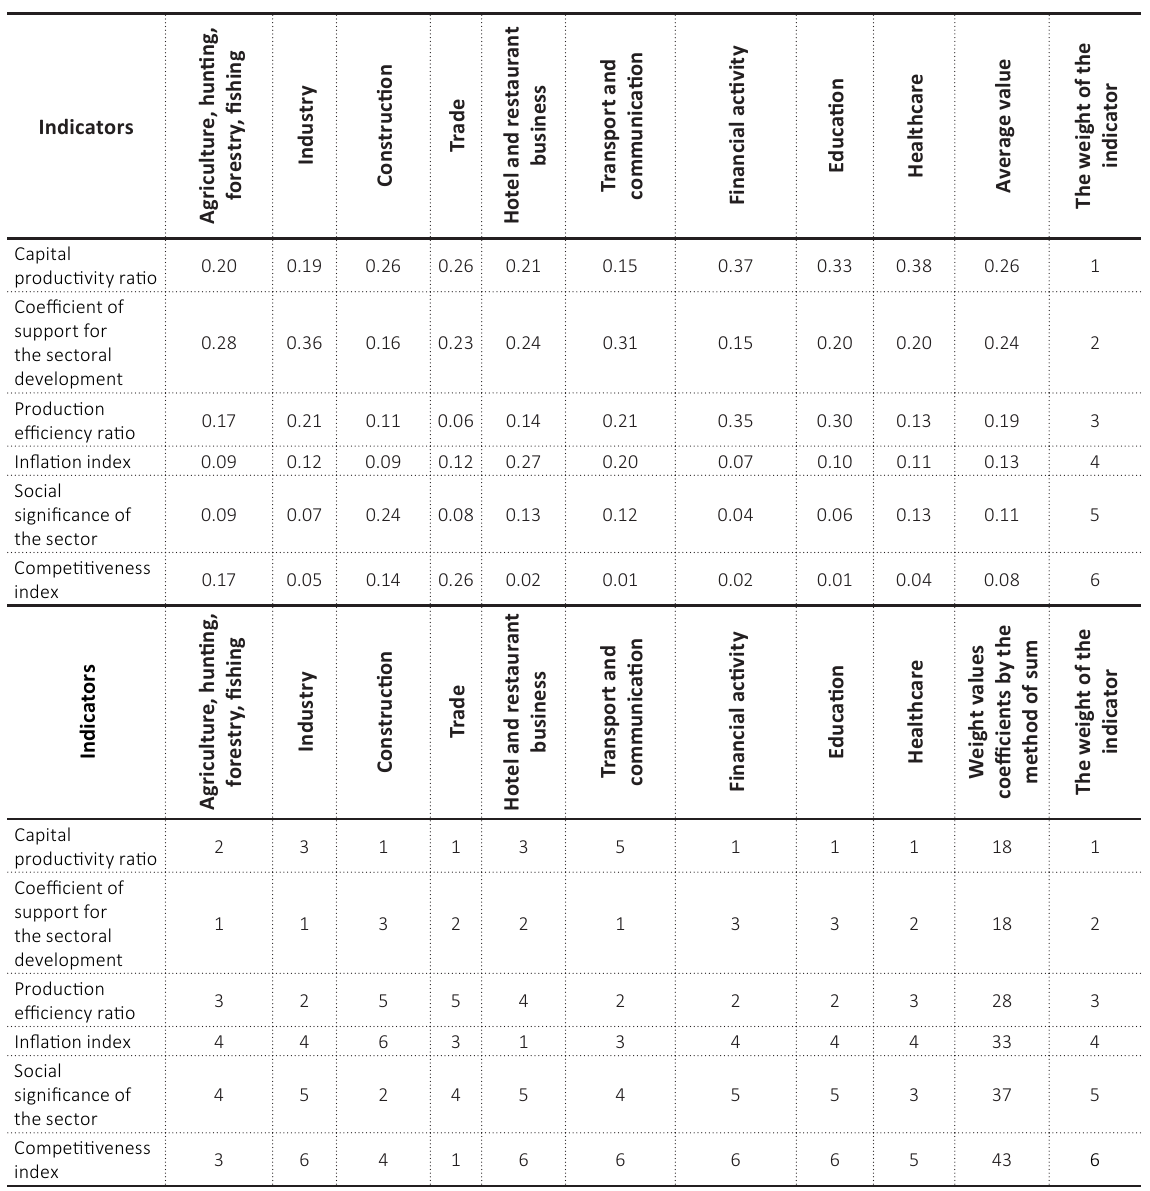
Table 2. Determining the most influential group of